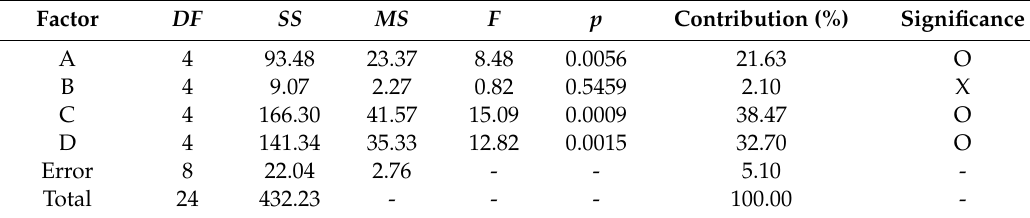
Table 8. Results of ANOVA for UF